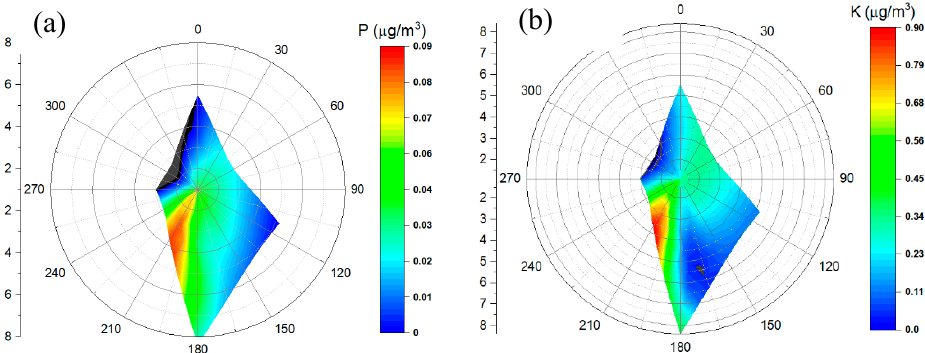
Figure 5. ( a ) Polar contour maps in relation to wind direction and speed for phosphorus (P) and ( b ) potassium (K) at the Gabriel de Castilla Spanish Research Station (Deception Island).